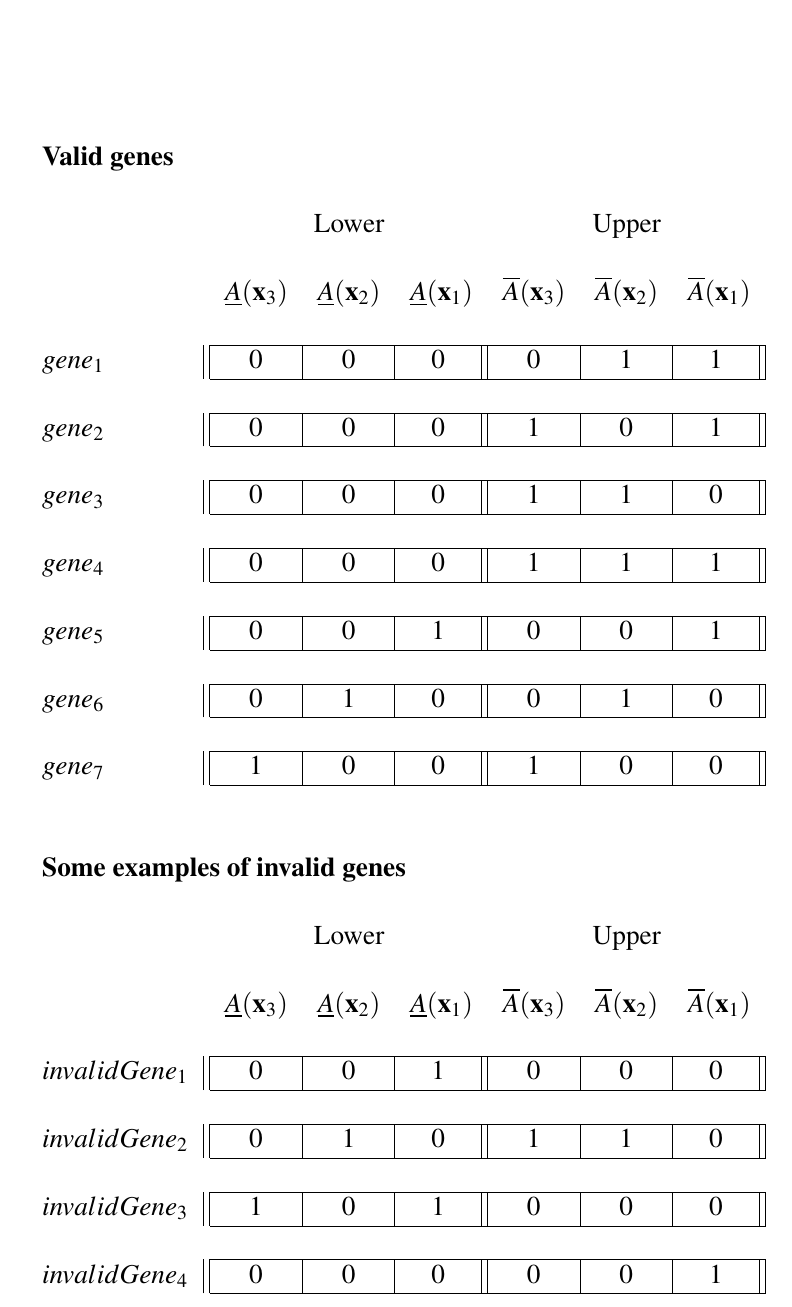
Figure 4: Genes in a rough set